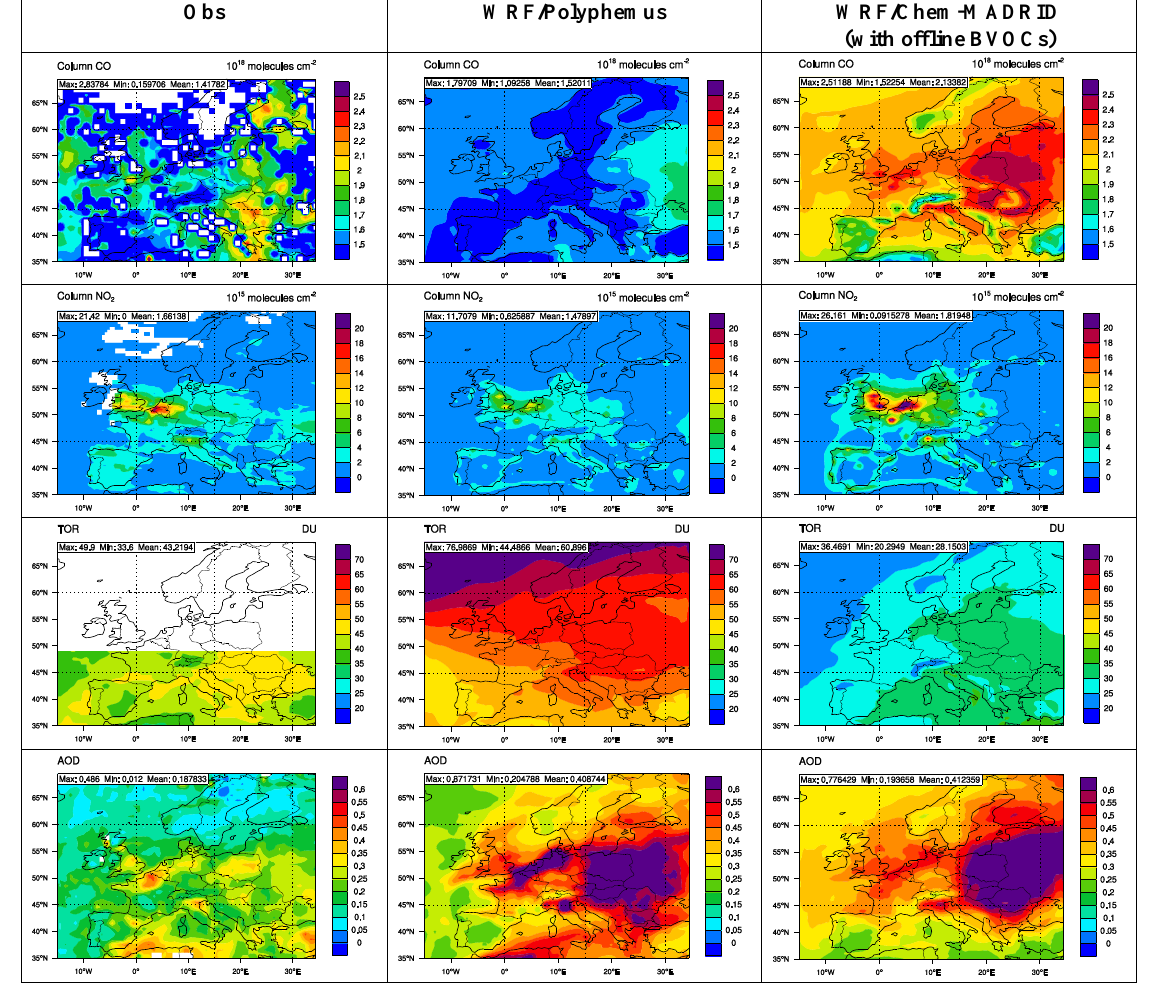
Figure 9. Simulated and observed monthly mean column mass abundance of CO and NO 2 , tropospheric ozone residual (TOR), and aerosol optical depths (AOD) over D01.